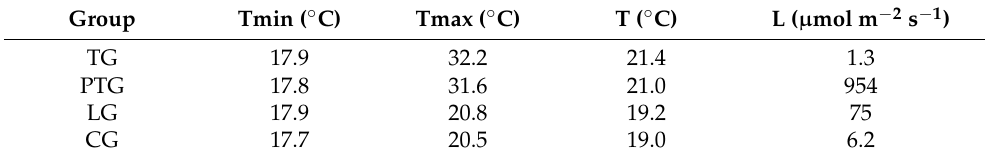
Table 2. Soil surface temperature and light intensity under different photo-thermal treatments. Group Tmin ( °C )